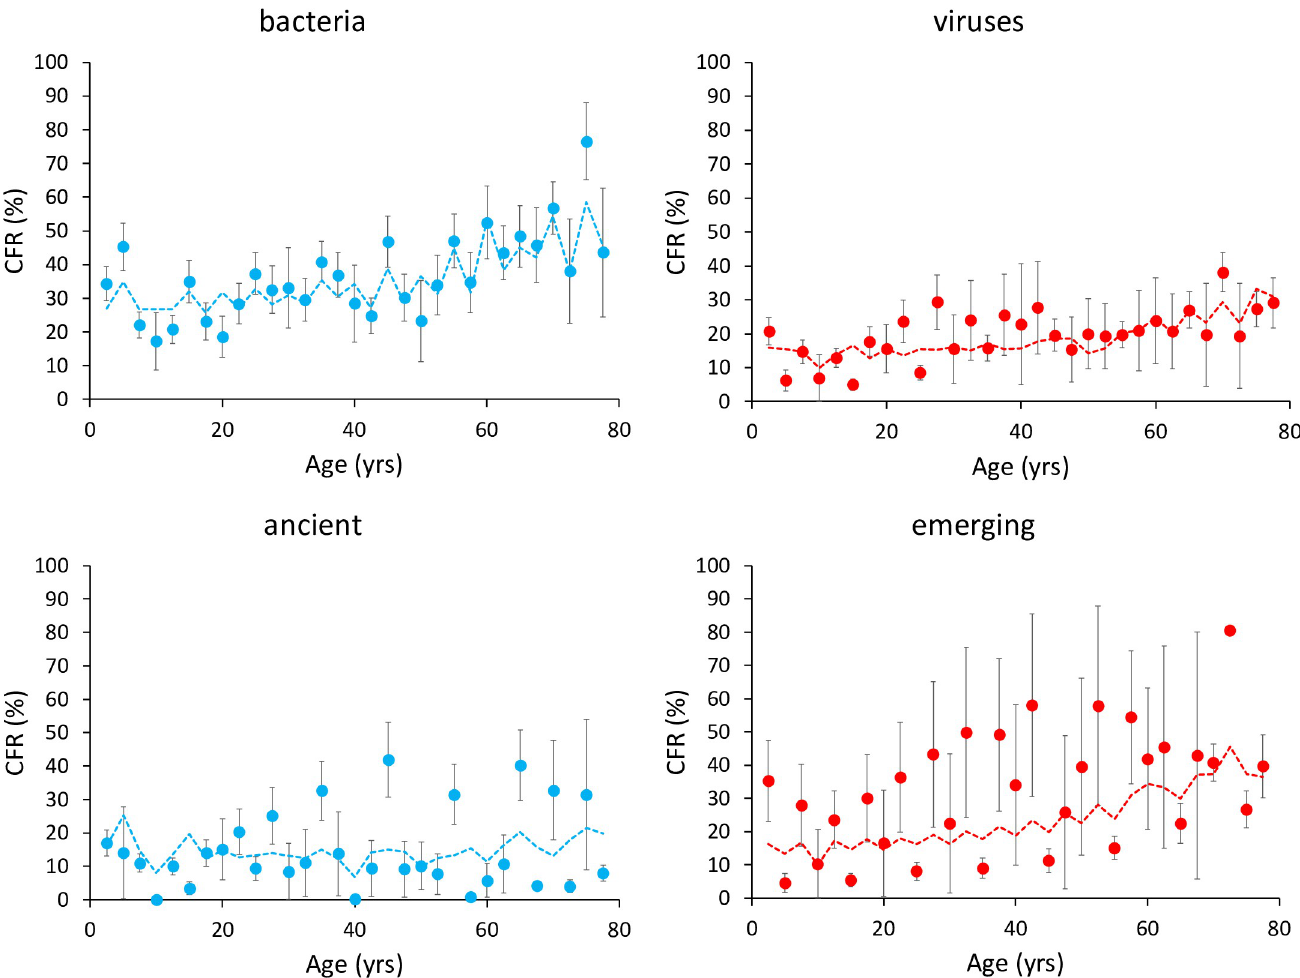
Fig 3. Age-dependent variation in CFR (%) for bacterial and viral diseases (above) and emerging and ancient viral diseases (below). Each dot represents the mean CFR for each age class and the bars the standard errors. The dotted lines represent the fit of the finite mixture model with a beta-binomial distribution of errors (number of deaths/number of